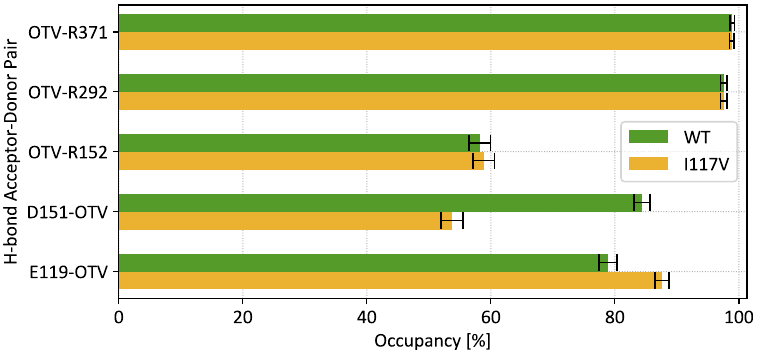
Figure 2 Hydrogen bond occupancies of oseltamivir for the wild-type (WT) and I117V mutant neuraminidases. In hydrogen bonding with OTV, the side chains of E119 and D151 acted as hydro- gen acceptors, while the side chains of R152, R292, and R371 acted as hydrogen donors. Error bars represent 95% con fi dence